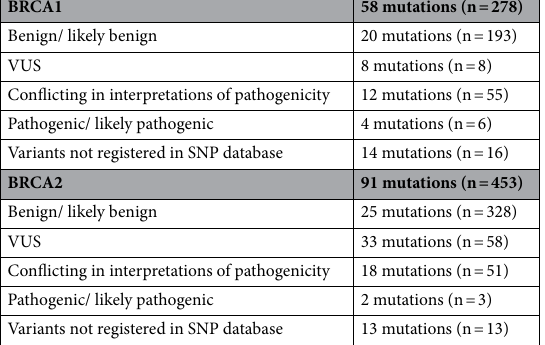
Table 1. Reclassification of patients diagnosed with variants of uncertain significance based on ClinVar data.